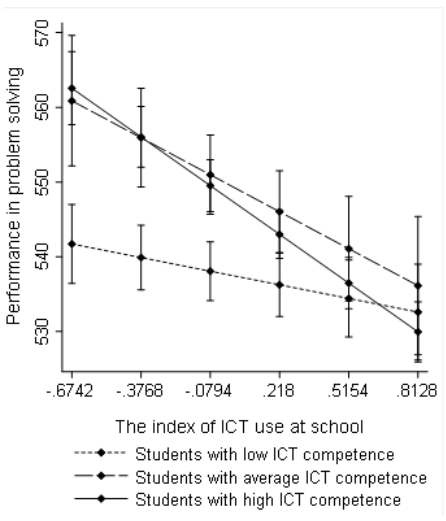
Figure 1. Predicted marginal means with 95% confidence intervals of students’ performance in scientific literacy (a), mathematical literacy (b), reading literacy (c), and collaborative problem solving (d) at different levels of ICT use at school (ranging from 10th percentile to 90th percentile) and among students with low (lowest 30%), average, and high (highest 30%) ICT competence. Adjusted for age, gender, the index of ESCS, and availability of ICT at